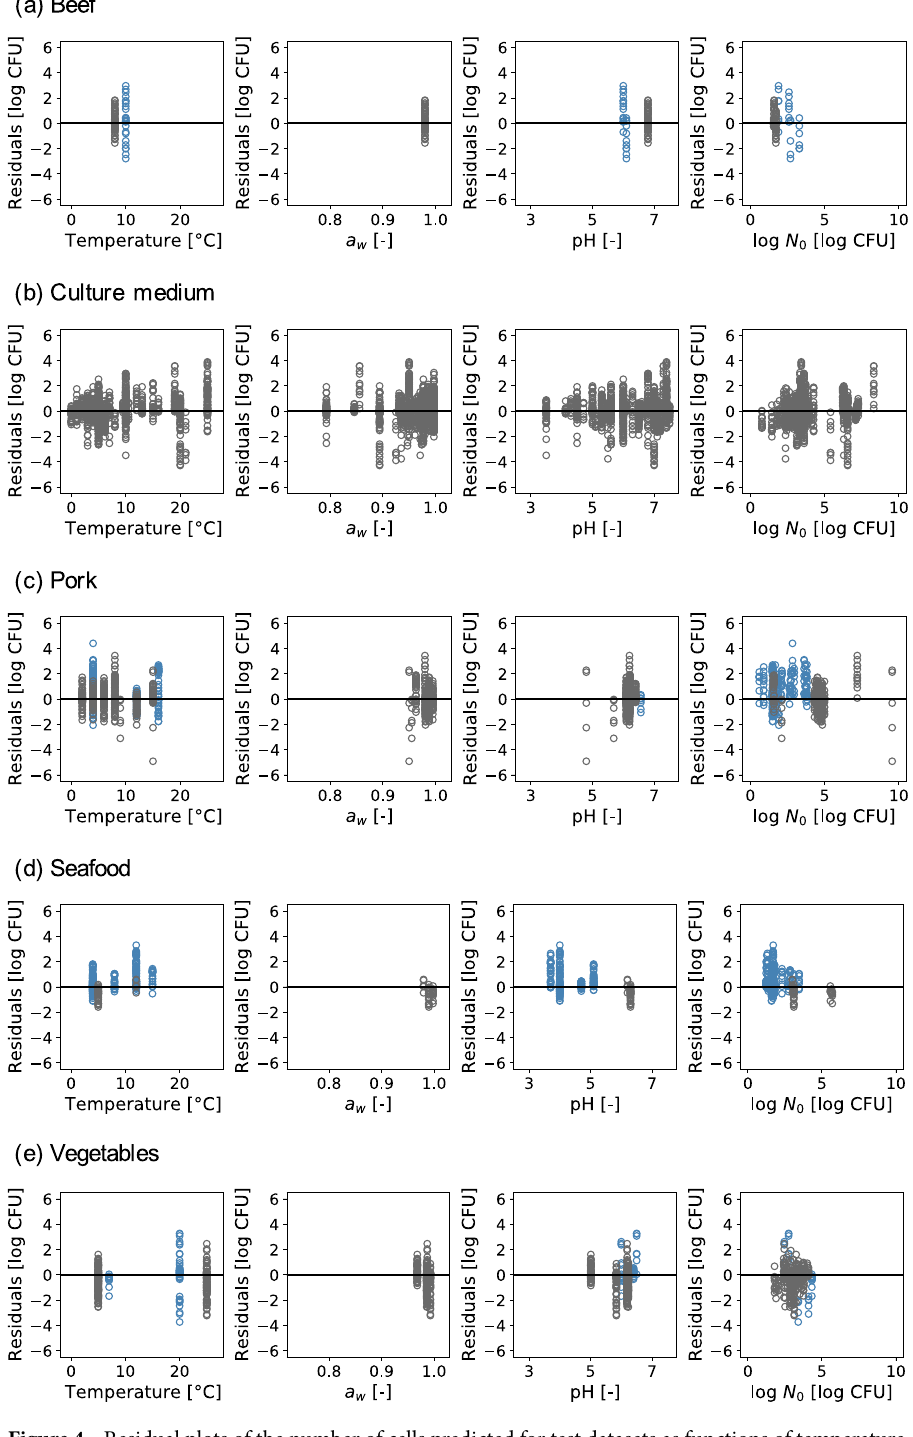
Figure 4. Residual plots of the number of cells predicted for test datasets as functions of temperature, a w , pH, and initial cell numbers for beef ( a ), culture medium ( b ), pork ( c ), seafood ( d ), and vegetables ( e ). The blue plots denote data lacking pH and/or a w , and the black ones denote data without missing values. The solid line represents residuals (r) = 0 (log